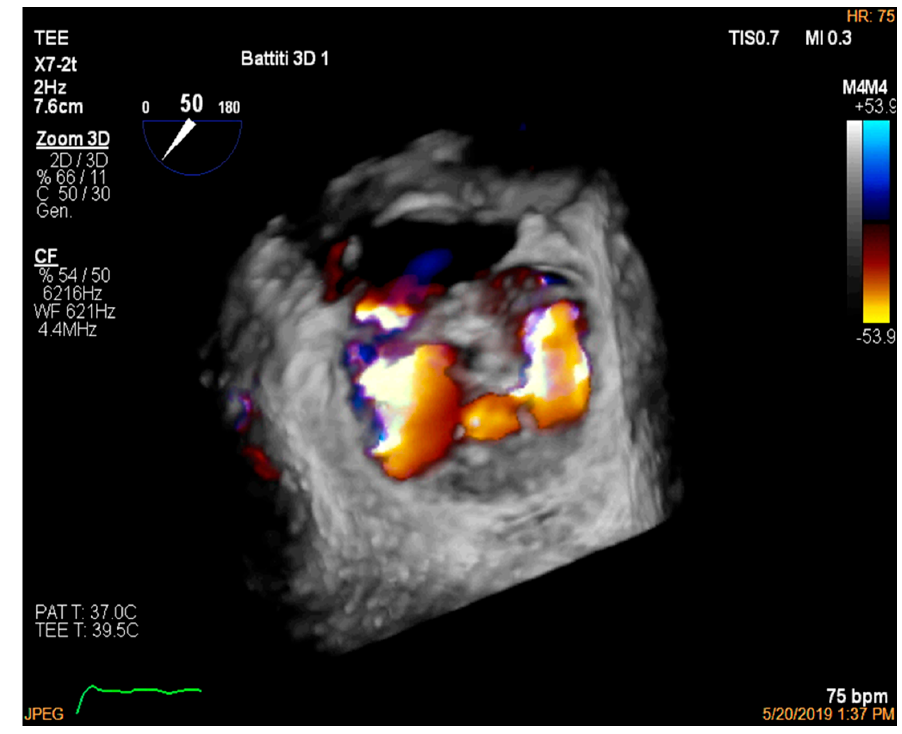
Figure 4. A live zoom 3D view at the end of the percutaneous correction procedure highlights a single centrally positioned clip with residual mild mitral insufficiency.